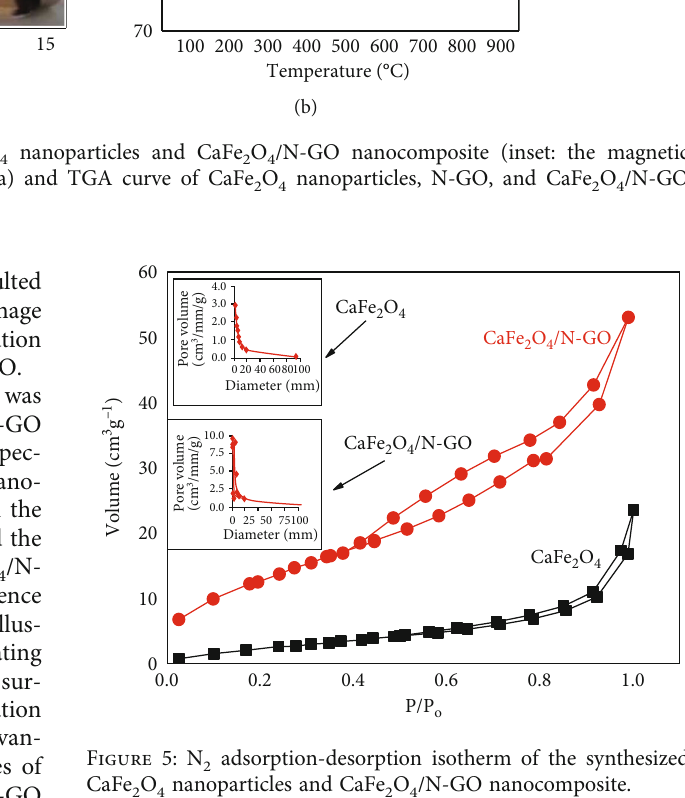
O nanoparticles and CaFe 2 4